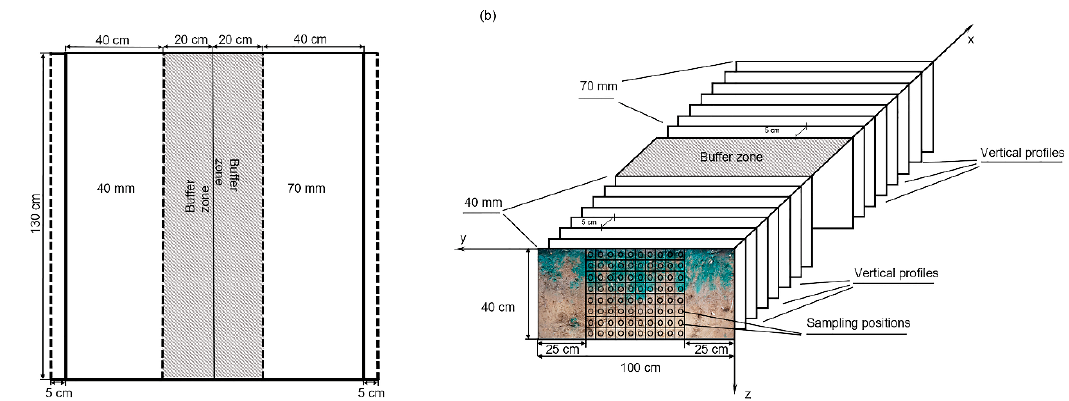
Figure 1. ( a ) Experimental set-up seen from above, ( b ) vertical soil profile excavation, and soil sample